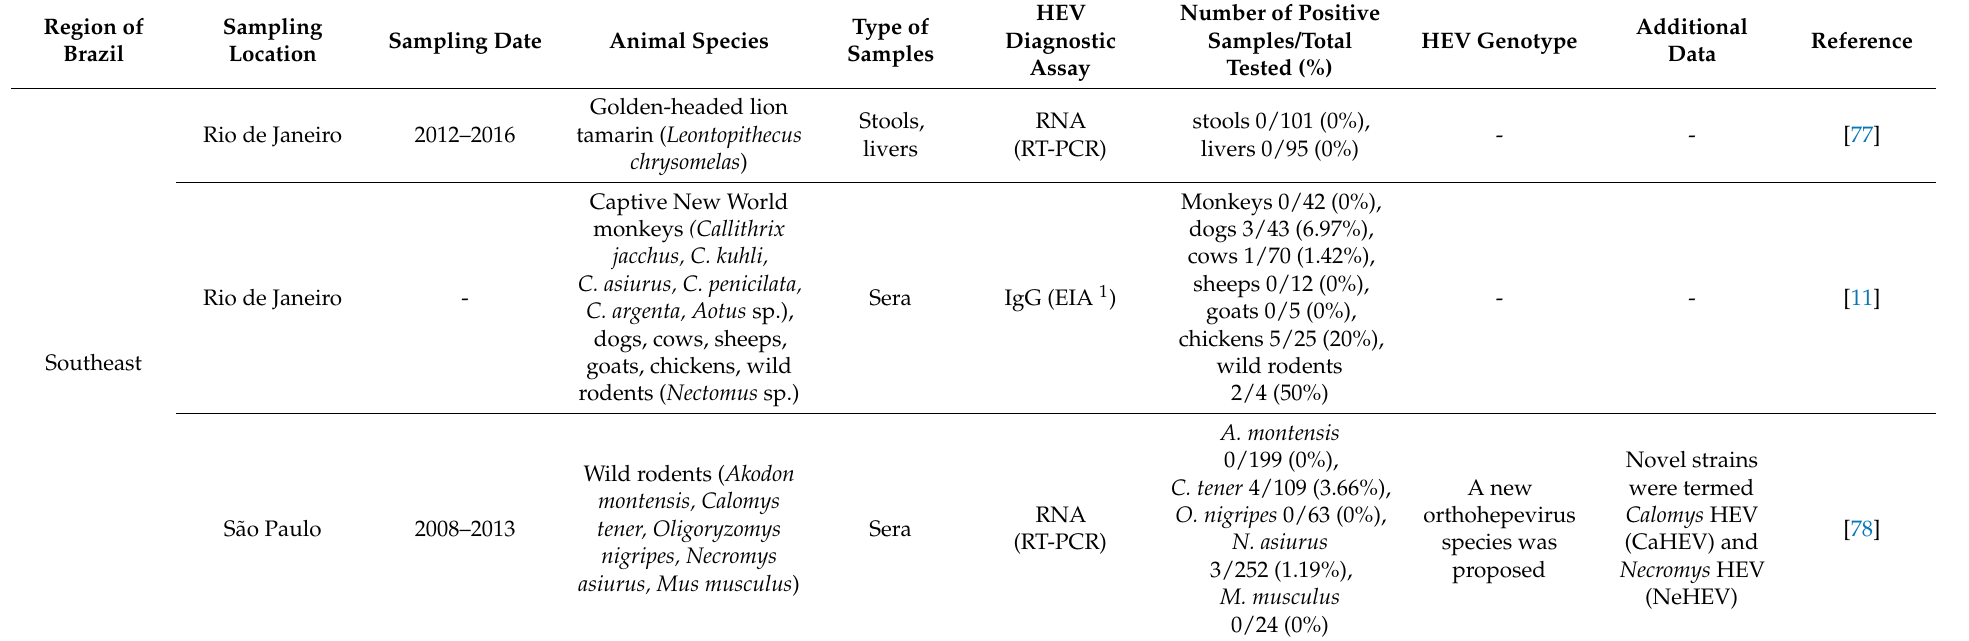
Table 3. HEV in animals other than swine, Brazil.